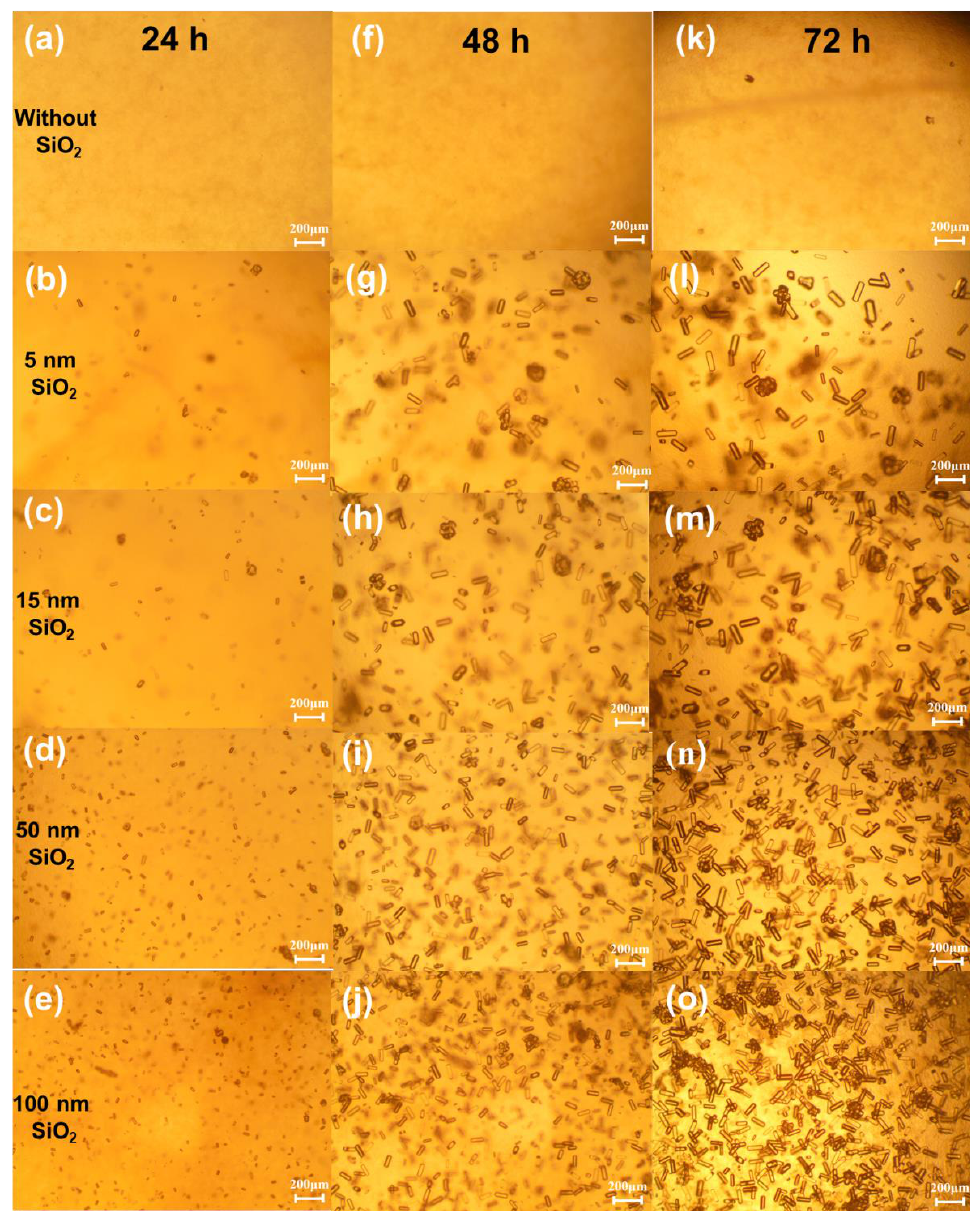
Figure 3. Microscopy photos of crystals obtained with SNP of different sizes. Conditions: 0.05 M, pH 4.5 sodium acetate buffer solution, 3 wt.% sodium chloride, 20 mg/mL lysozyme at 4 °C. Scale